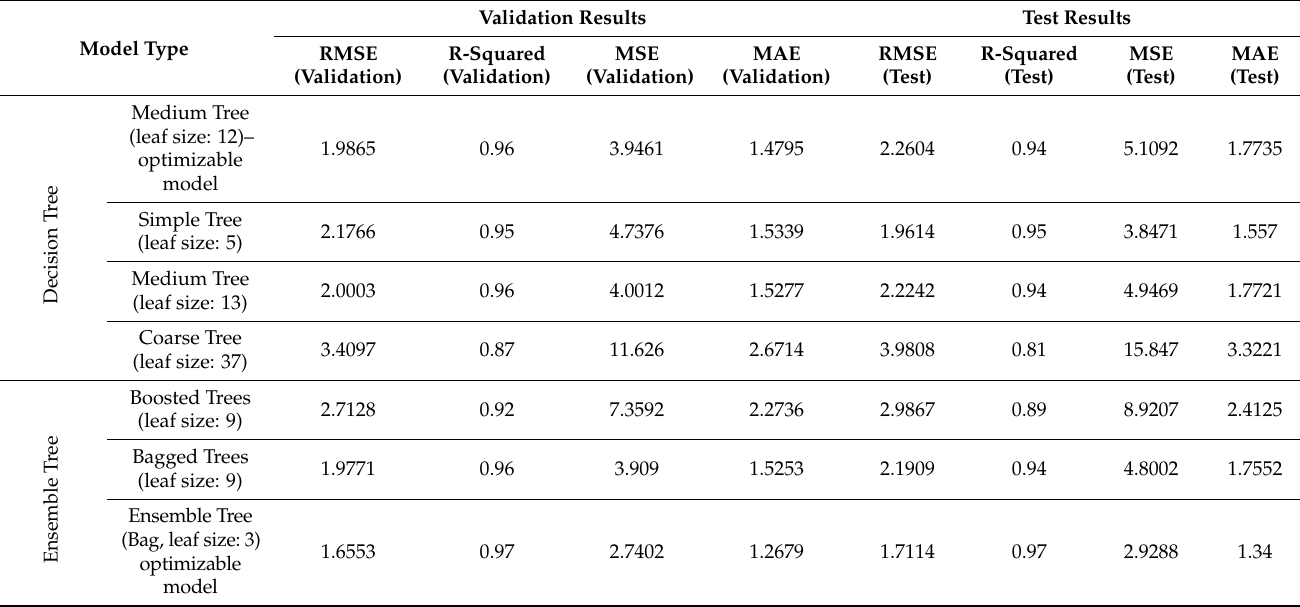
Table 2. Prediction errors with decision trees and ensemble